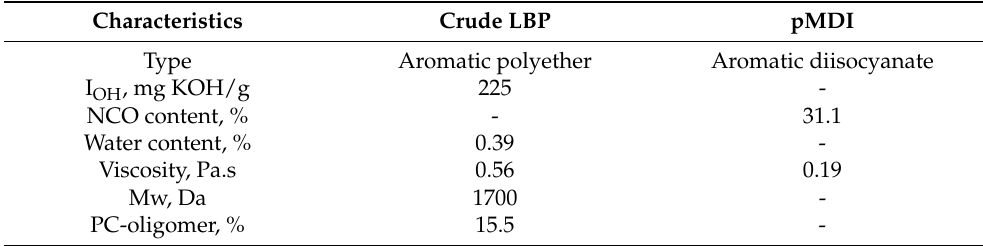
Table 1. Crude LBP and pMDI characteristics.